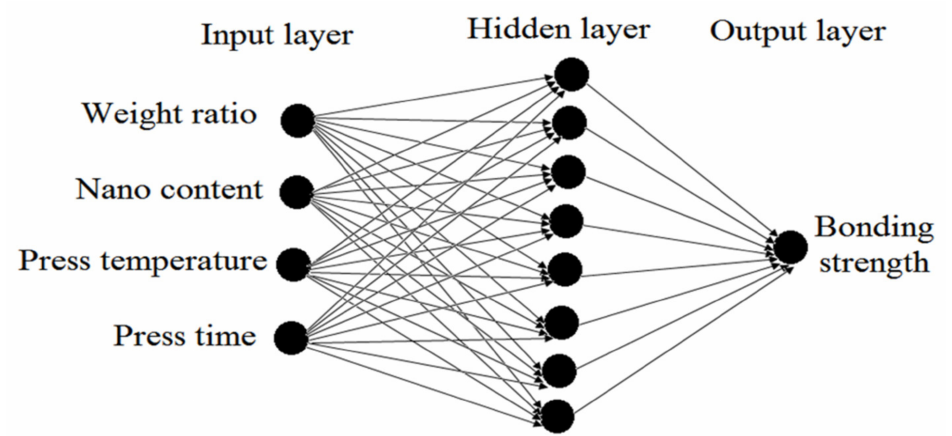
Figure 1. Actual architecture of ANN